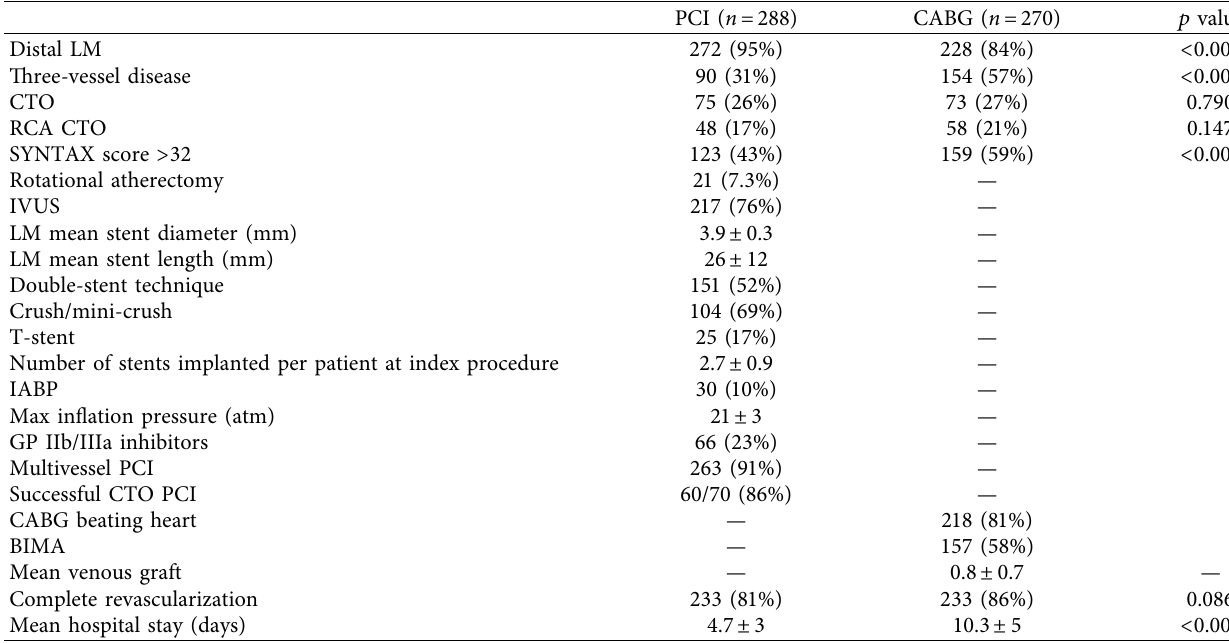
Table 2: Angiographic and procedural characteristics.